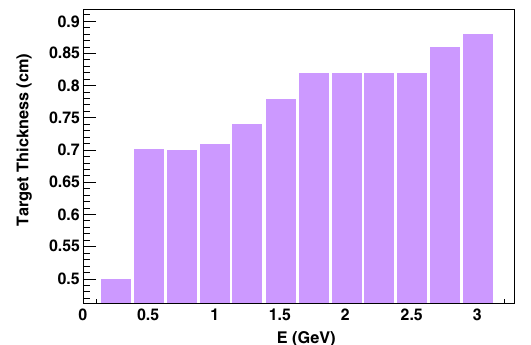
FIG. 9. Pion momentum and energy spectra for incident proton energy of 1